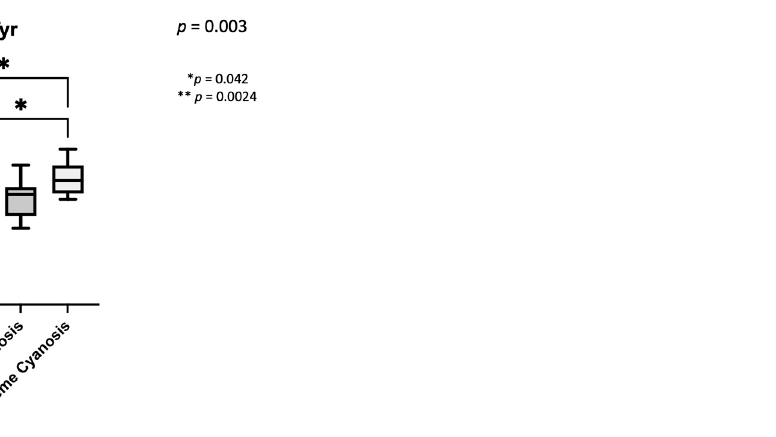
When analyzing the cohort considering aortic flow obstruction, no differences in o-